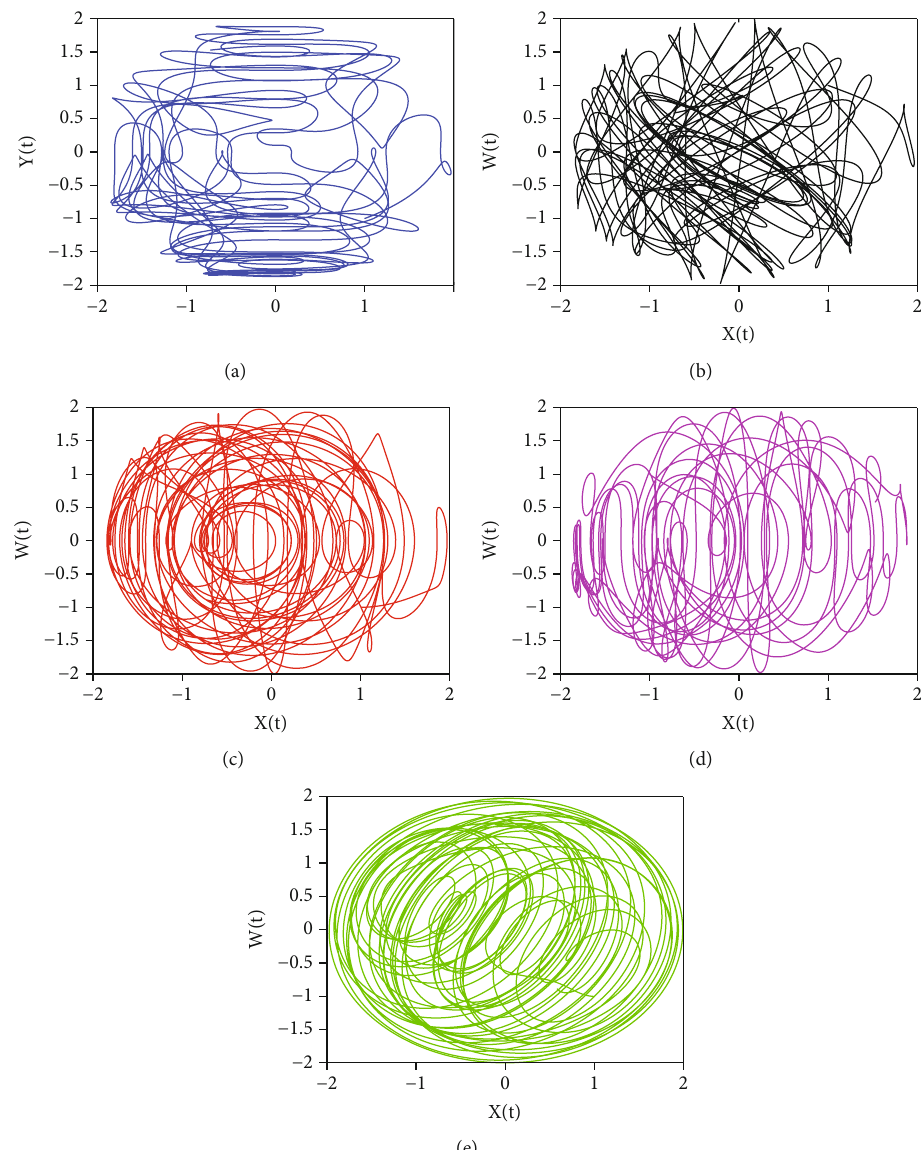
Figure 4: The behavior of di ff erent state variables of the system 1 with fractional order ϖ = 1 and the parameters are considered as c = d = 2